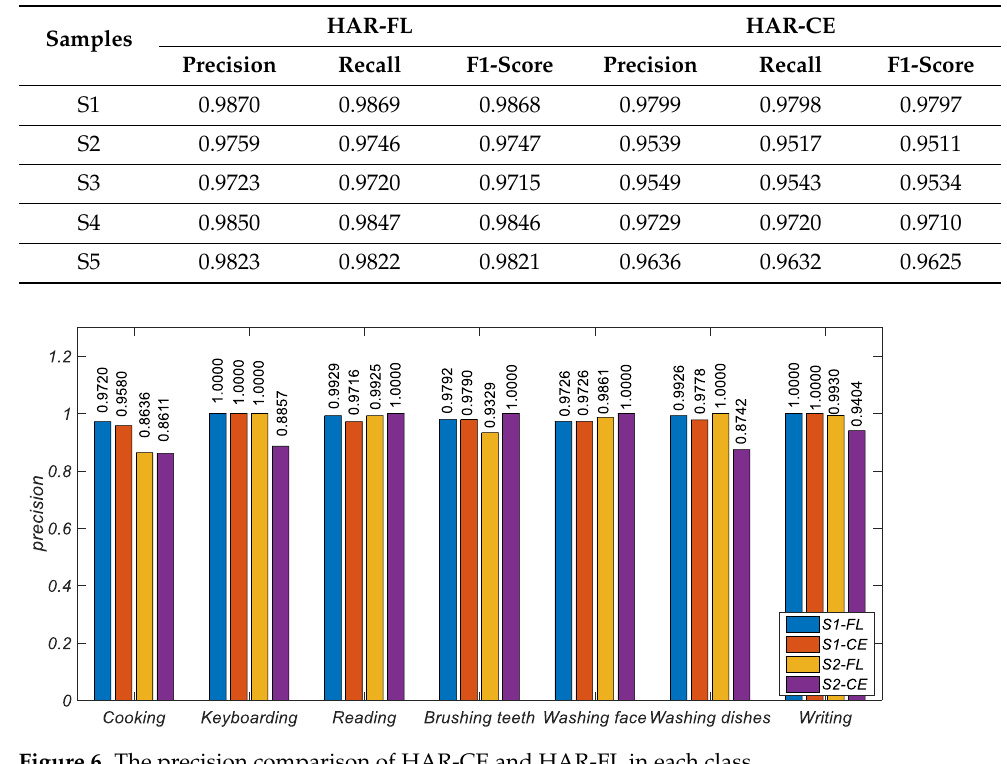
Figure 6. The precision comparison of HAR-CE and HAR-FL in each class.